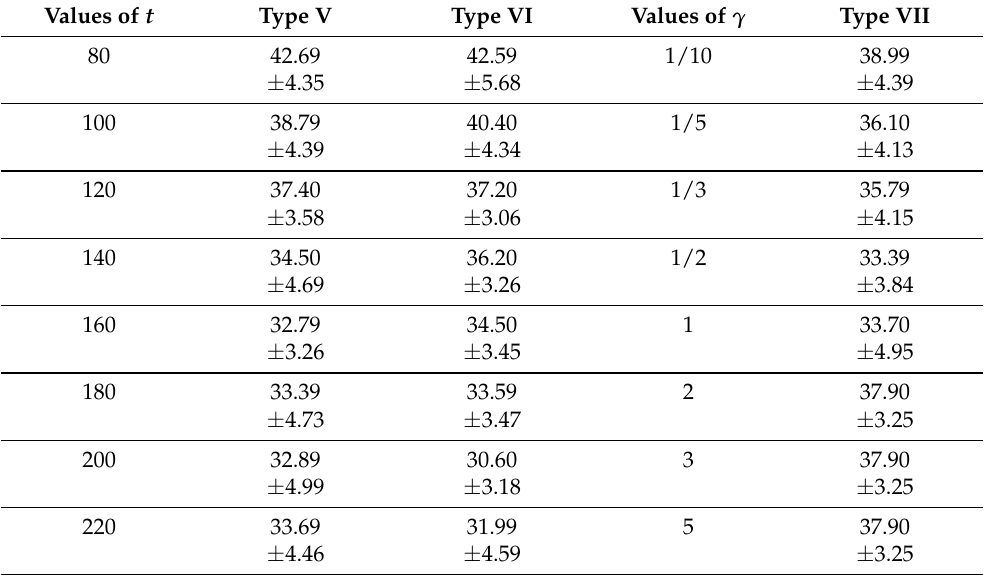
Table 4. Detail of the average error rates of the CNN with image correction methods of type V, VI, and VII.